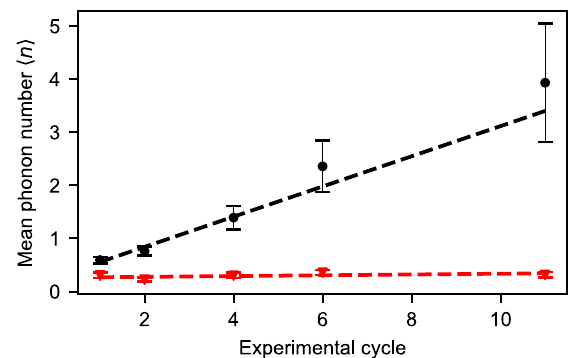
FIG. 5. Suppression of the heating of the x WCR mode. Without additional algorithmic cooling, the ion heats up due to the anomalous electric-field noise (black circles). A linear fit (black dashed line) implies a heating rate of 8.9(16) phonons/ second, consistent with the previously measured value for this mode (see Table I). With one algorithmic cooling cycle applied on each WCR mode per experimental cycle, this heating is suppressed (red triangles), with a fitted heating rate of 0.18(15) phonons/second (red dashed line). The cycles have a duration of 32 ms without algorithmic cooling and 41 ms with algorithmic